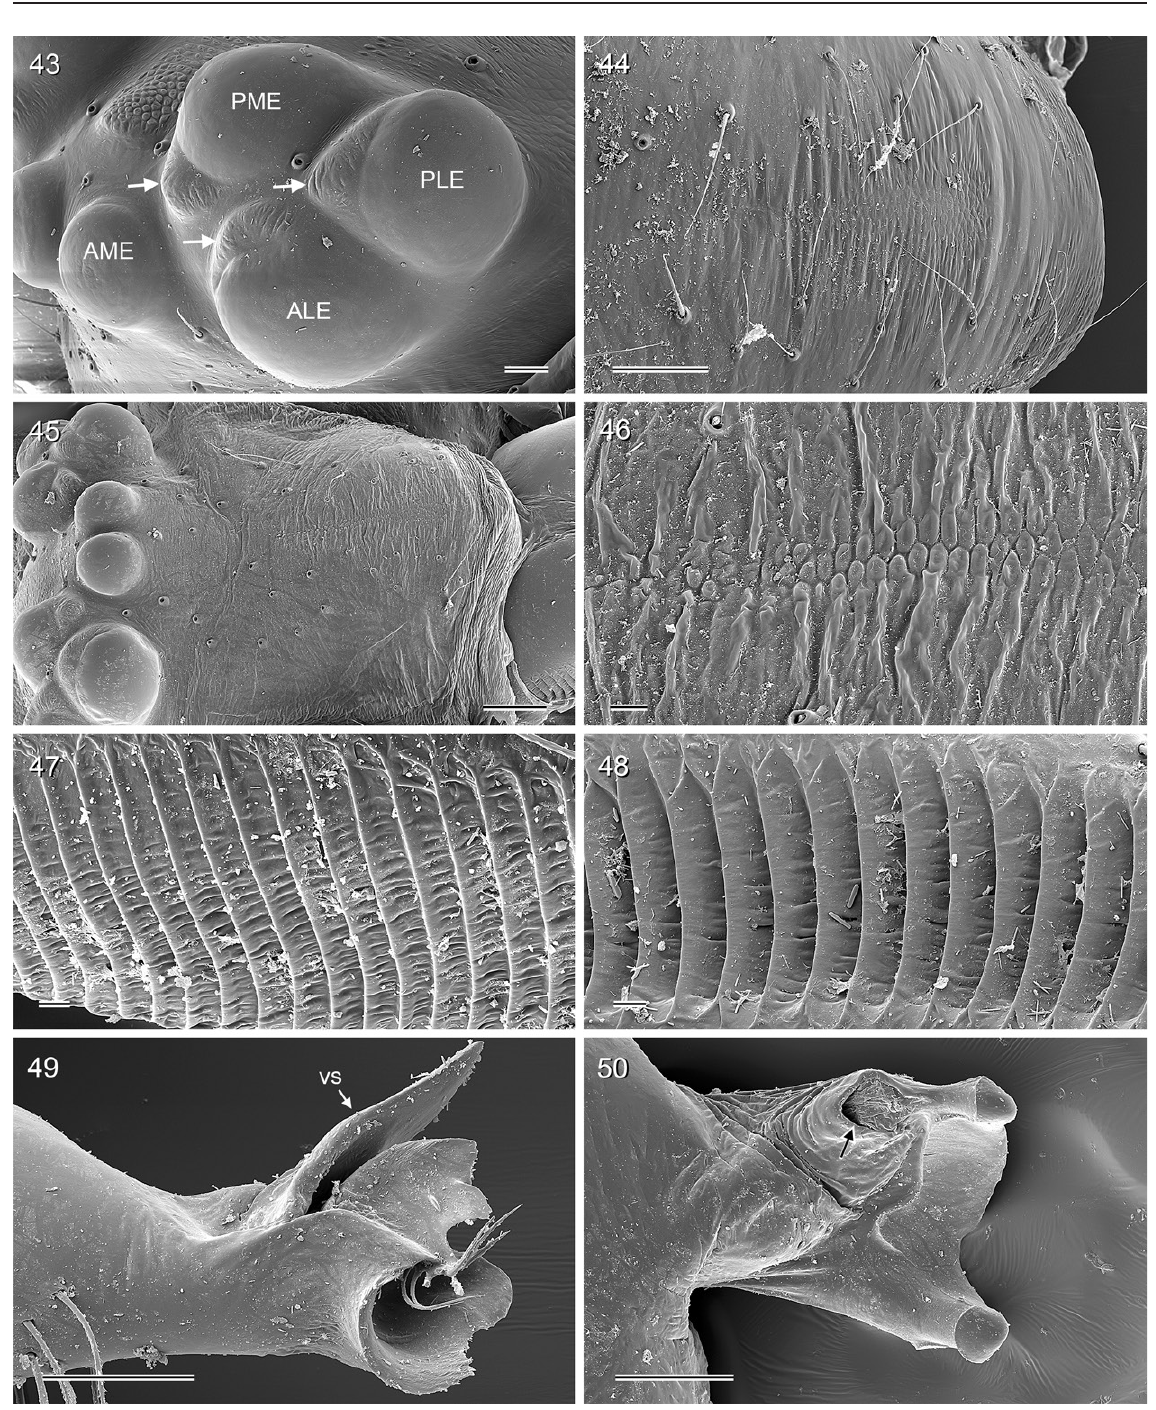
Figs 43–50. Holocnemus pluchei (Scopoli, 1763); male and female from Greece, Daphni/Athens (MHNG). 43 . Left male ocular area, oblique view; arrows: ‘accessory lenses’. 44 . Male clypeus, frontal-dorsal view. 45 . Female ocular area and clypeus, oblique frontal view. 46 . Detail of preceding figure. 47–48 . Stridulatory files on male and female chelicerae. 49 . Left procursus, retrolateral view. 50 . Distal (main) sclerite of left genital bulb, prolateral (slightly distal) view; arrow: sperm duct opening. Abbreviation: vs = ventral sclerite. Scale bars: 43 = 30 µm; 44–45, 49–50 = 100 µm; 46–48 = 10